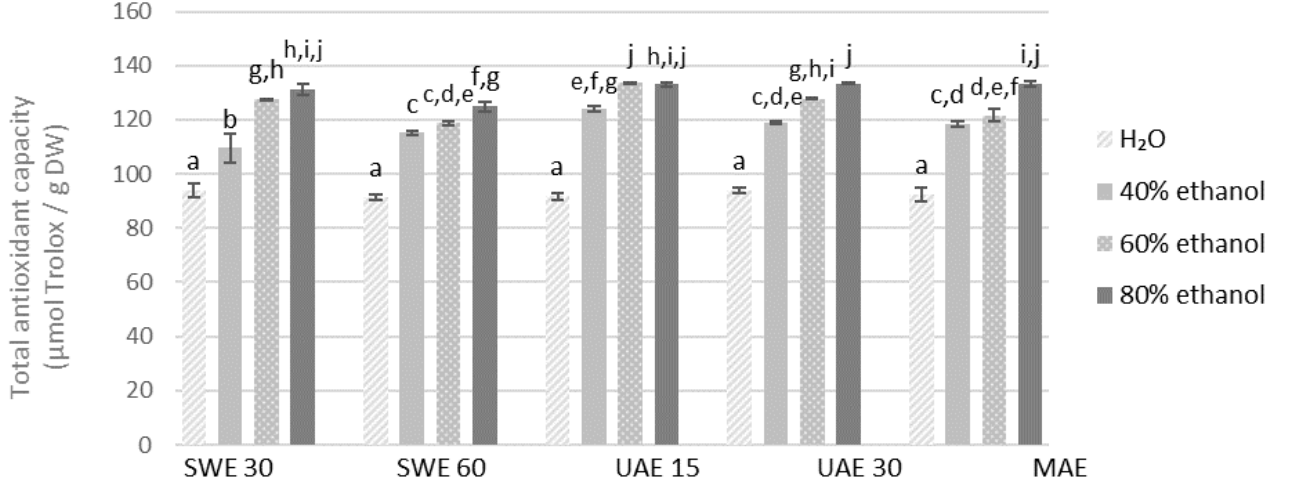
Figure 5. Antioxidant capacity of the extracts obtained from the fraction with particle size ≤ 0.5 mm determined by the method with DPPH radicals. SWE—shaking water bath extraction; UAE— ultrasound-assisted extraction; MAE—microwave assisted extraction; 15, 30 or 60-time of extraction. Results are presented as the mean ± SD from triplicate determinations. Different letters: a, b, c, d, e, f, g, h, i, j indicate that samples are significantly different. The letter “a” marks the lowest value. Higher values are marked with consecutive letters of the alphabet. Bars that share the same letter within the group are not significantly different according to Tukey’s HSD test at p > 0.05.